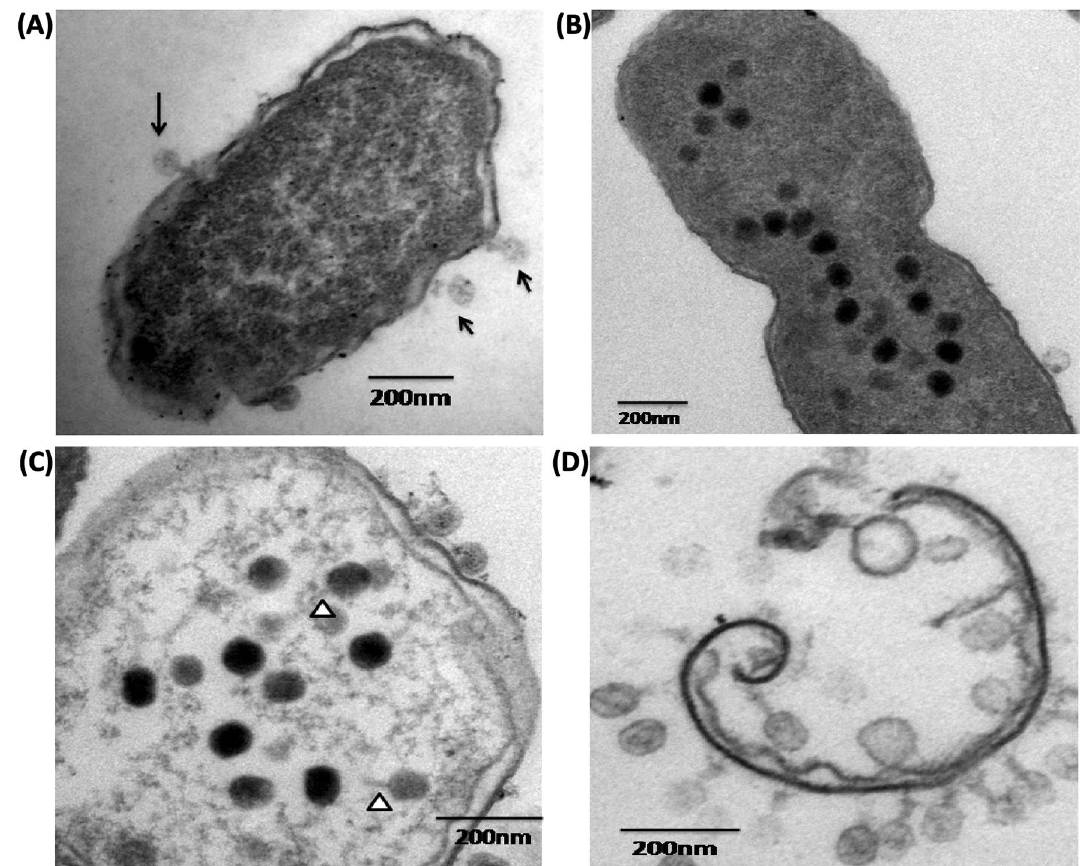
Figure 4. TEM images of ultrathin section of Shigella flexneri 2a infected with isolated host specific bacteriophage at different time points: ( A ) Bacteriophage attachment started at 15 min (black arrow indicates phage particles), ( B ) TEM image of 30 min shows intracellular phage development started, ( C ) Intracellular phage, loss of internal material and membrane disorganization is also shown. White arrowheads indicate phage tail. ( D ) Complete lysis of bacteria cell clearly shown at 60 min. Scale bar-200